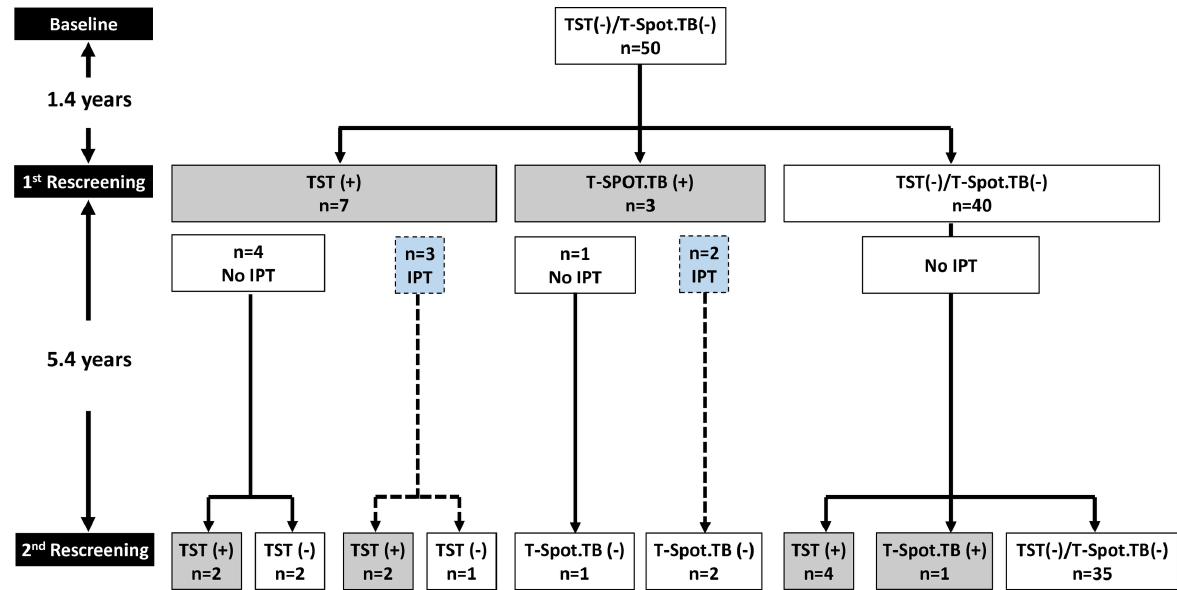
Figure 1. Flow chart of rheumatic patients with negative baseline TB screening. The flow chart of the 50 patients with negative baseline tuberculosis (TB) screening (by tuberculin skin test-TST and T-SPOT.TB) who were included in the study is depicted. The mean time (in years) between baseline and first rescreen- ing as well as between the first and second rescreening is shown in the left side of the figure. Patients who converted at the first rescreening and were treated with IPT (isoniazid preventive therapy) are also shown (blue boxes and dashed